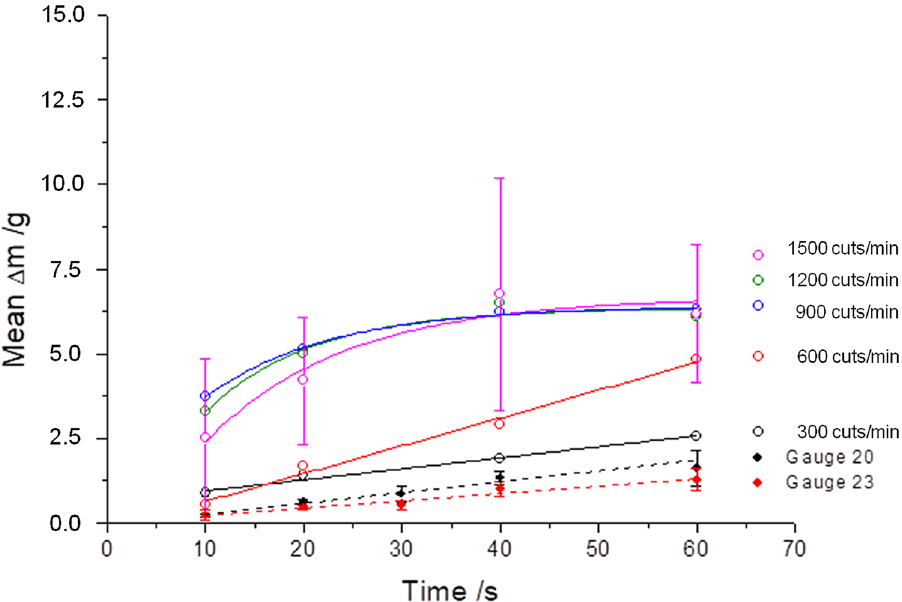
Figure 5. Aspiration rates using a Mark I handpiece (Gauge 19) at a pulse energy of 3 mJ (Fig. 2b) compared to a mechanical cutter with two different applicator tips [Gauge 20 and 23 at 800 cuts/min (13.33 Hz)] as a clinical reference. Due to the low aspiration rates of the mechanical cutter, only pulse energies of ≤ 3 mJ were used for Mark II and III handpieces.